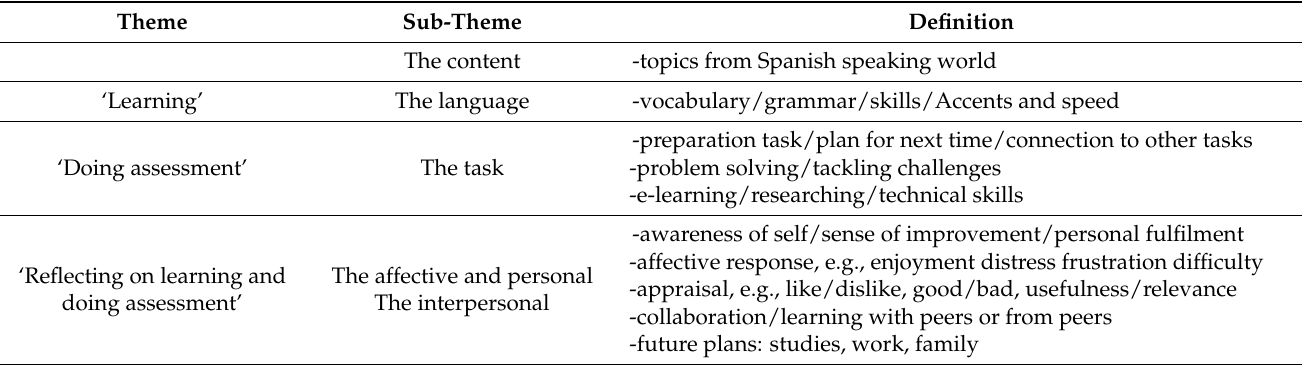
Table 3. Coding themes, subthemes, and